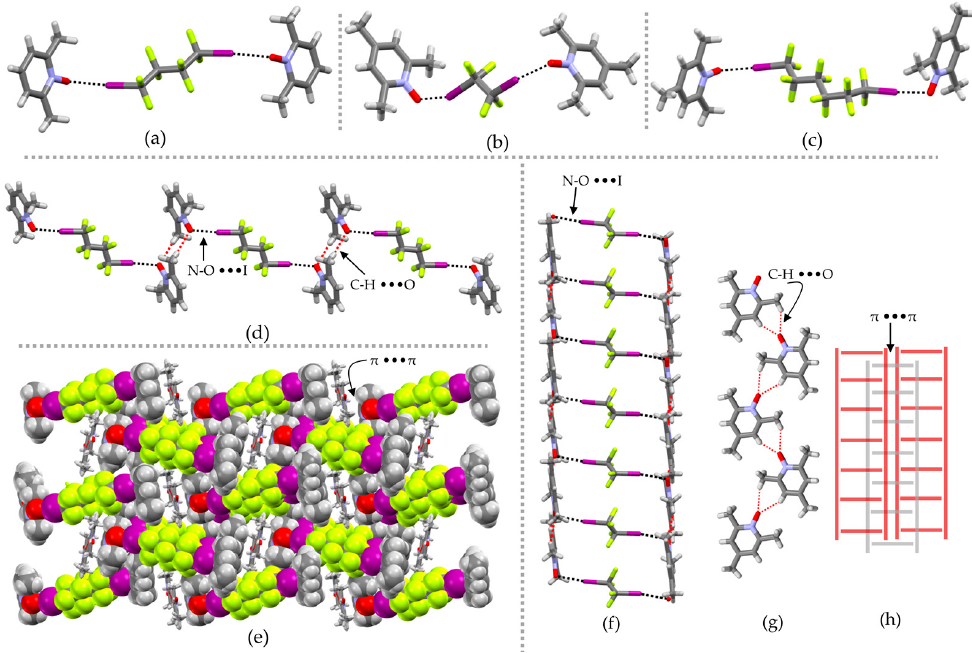
Figure 7. 2:1 Acceptor-donor discrete structures in 5•DI4 ( a ) 8•DI2 ( b ) and 8•DI6 ( c ). The C − H···O interactions connect the 2:1 units in 5•DI4 ( d ). Complex crystal packing in 8•DI6 displaying π ··· π